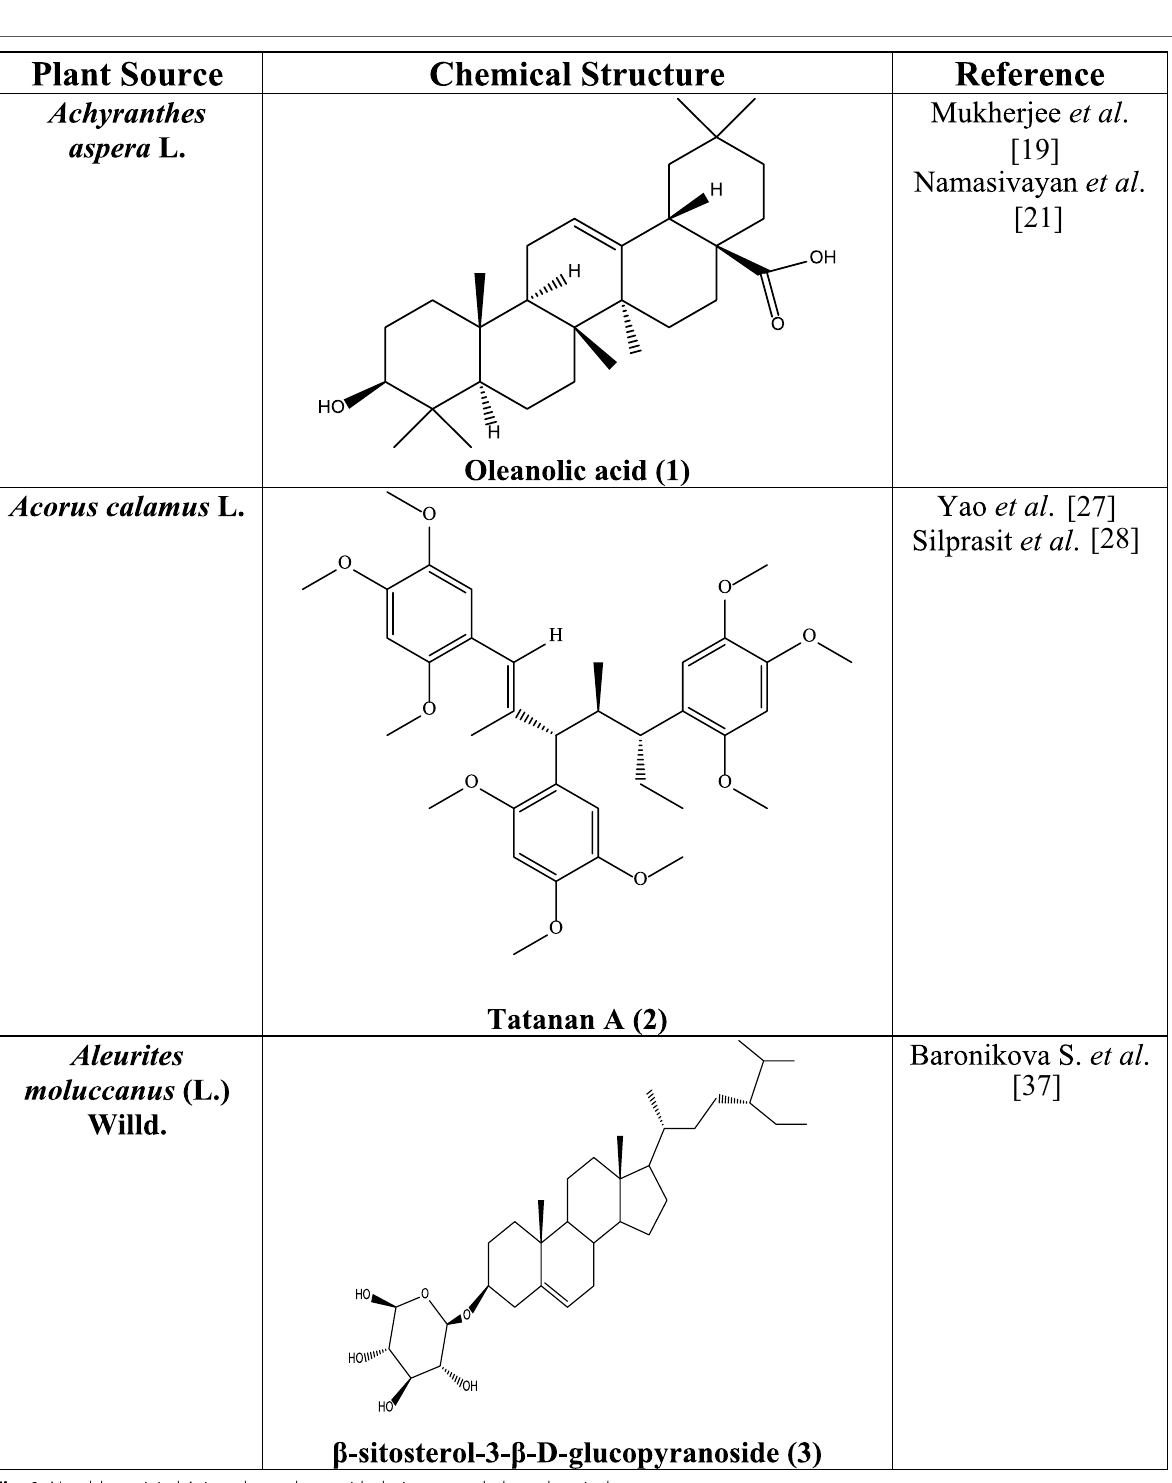
Fig. 1 Notable antiviral Asian plants along with their reported